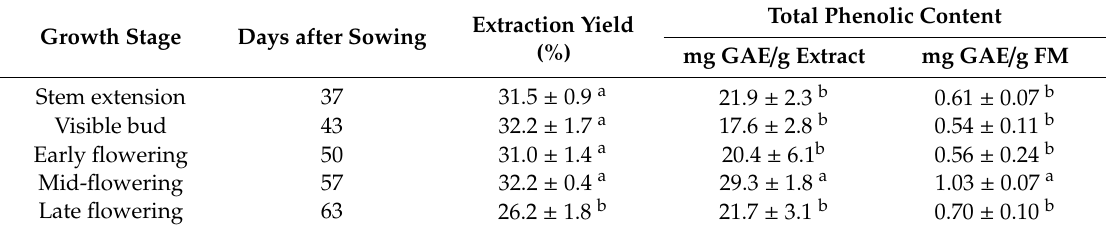
Table 1. Total phenolic content of the sunflower extract and fresh matter (FM) of the plants at various growth